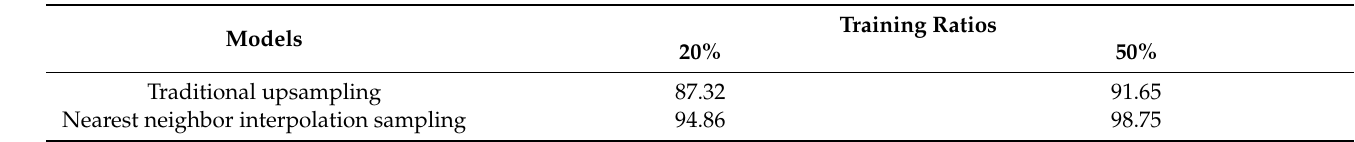
Table 6. Influence of traditional upsampling method and nearest neighbor interpolation sampling method on classification accuracy.